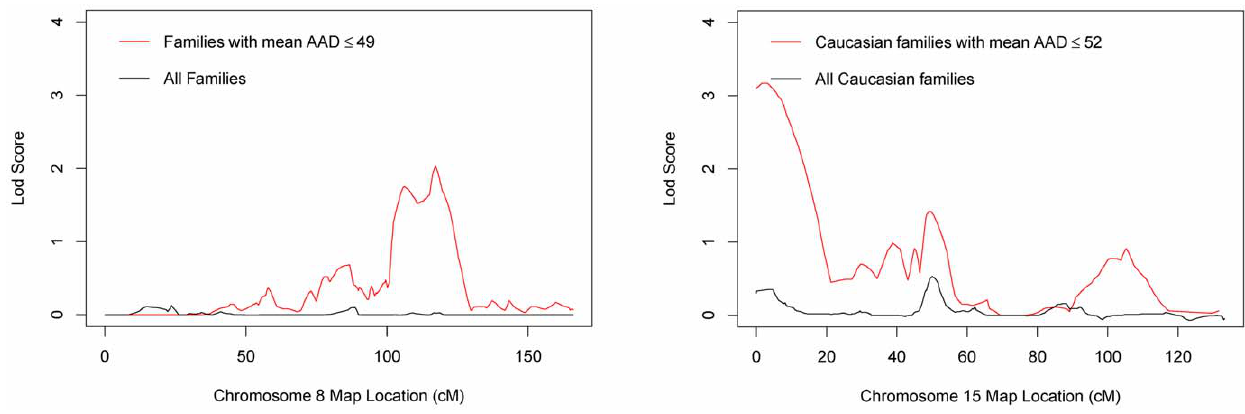
Figure 4. OSA results for chromosomes 8 and 15. Ordered subset analysis (red line) indicates improved evidence for linkage to chromosome 8 (left panel) among families with a mean age of onset # 49 years. The black line plots non-parametric linkage analysis in all families in the combined dataset. Improved evidence for linkage to chromosome 15 (right panel) was demonstrated among Caucasian families with a mean age of onset # 52 years. The black line plots non-parametric linkage analysis in all Caucasian